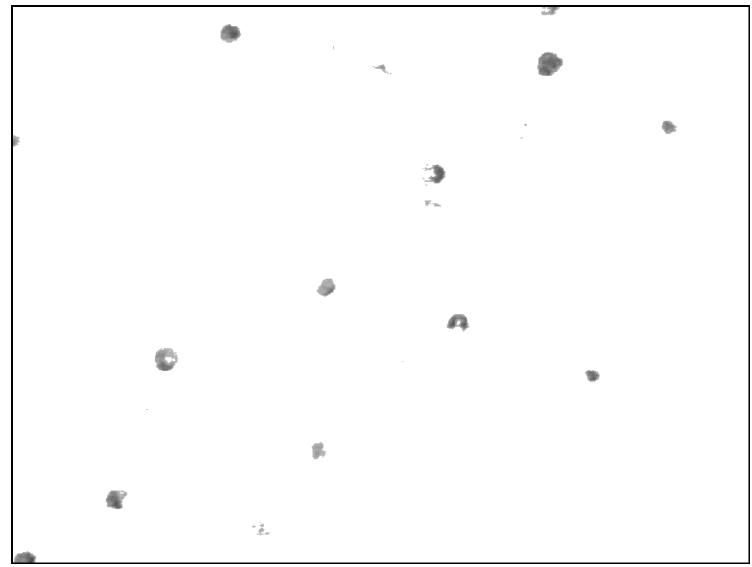
Fig. 3. Segmented control nuclei. These are to be segmented into two